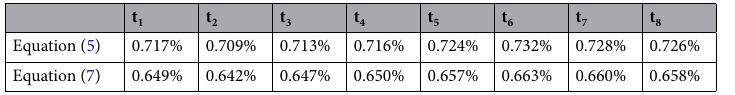
2 i ( u num − u ana ) , where u is the velocity at the centerline of cross 2 ana i u (cid:31) (cid:30) (cid:30)